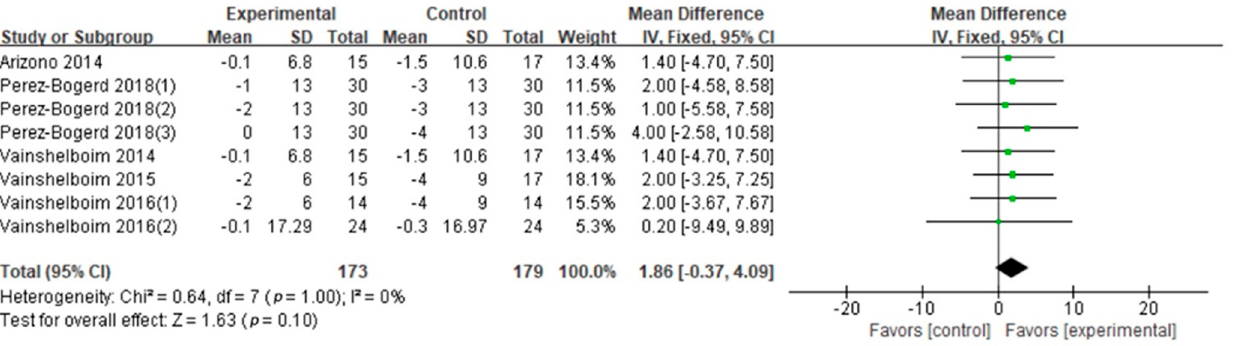
Figure 5. DLCO % pred.